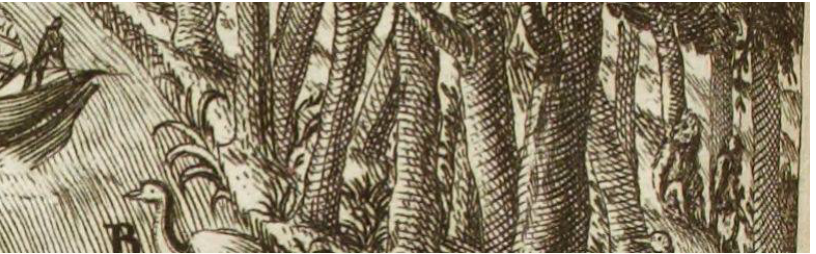
Figure 2. Detail of marginal figures on the right corner of Figure 1, Illustrated chapter heading of Book Three “On the Journey from Portobelo to Panamá” (Ulloa and Juan 1748, p. 144). John Carter Book Three “On the Journey from Portobelo to Panam á ” (Ulloa and Juan 1748, p. 144). John Carter Brown Library. Image used with permission. Brown Library. Image used with